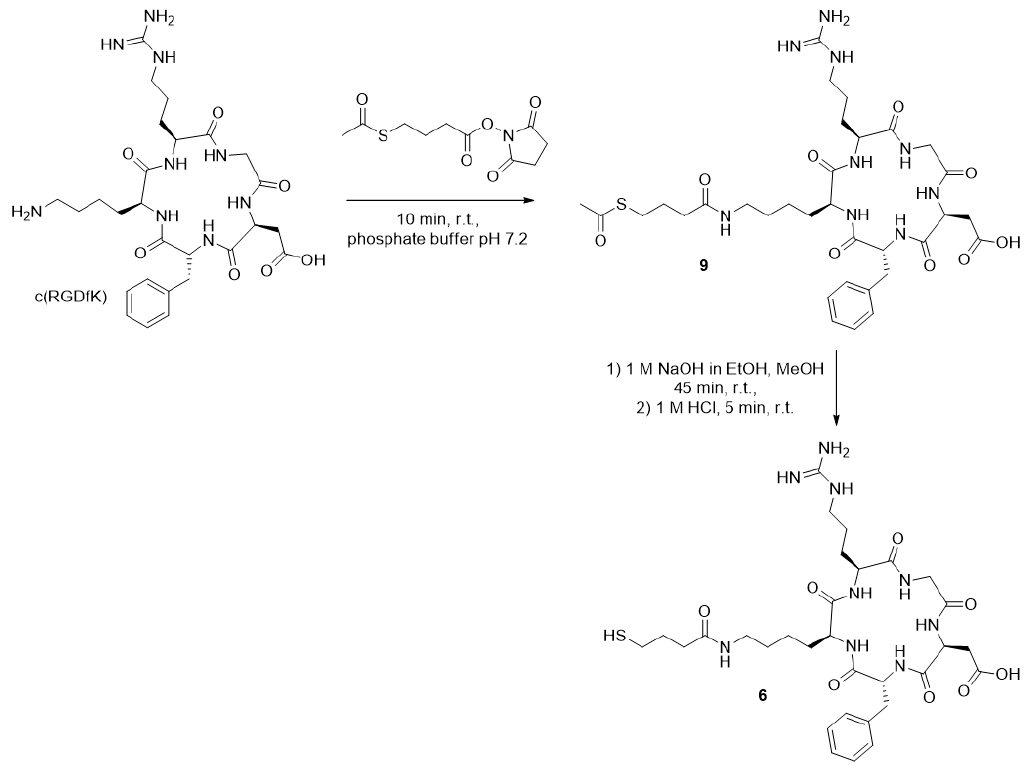
Figure A1. Synthesis of thiol-modified c(RGDfK) 6 .